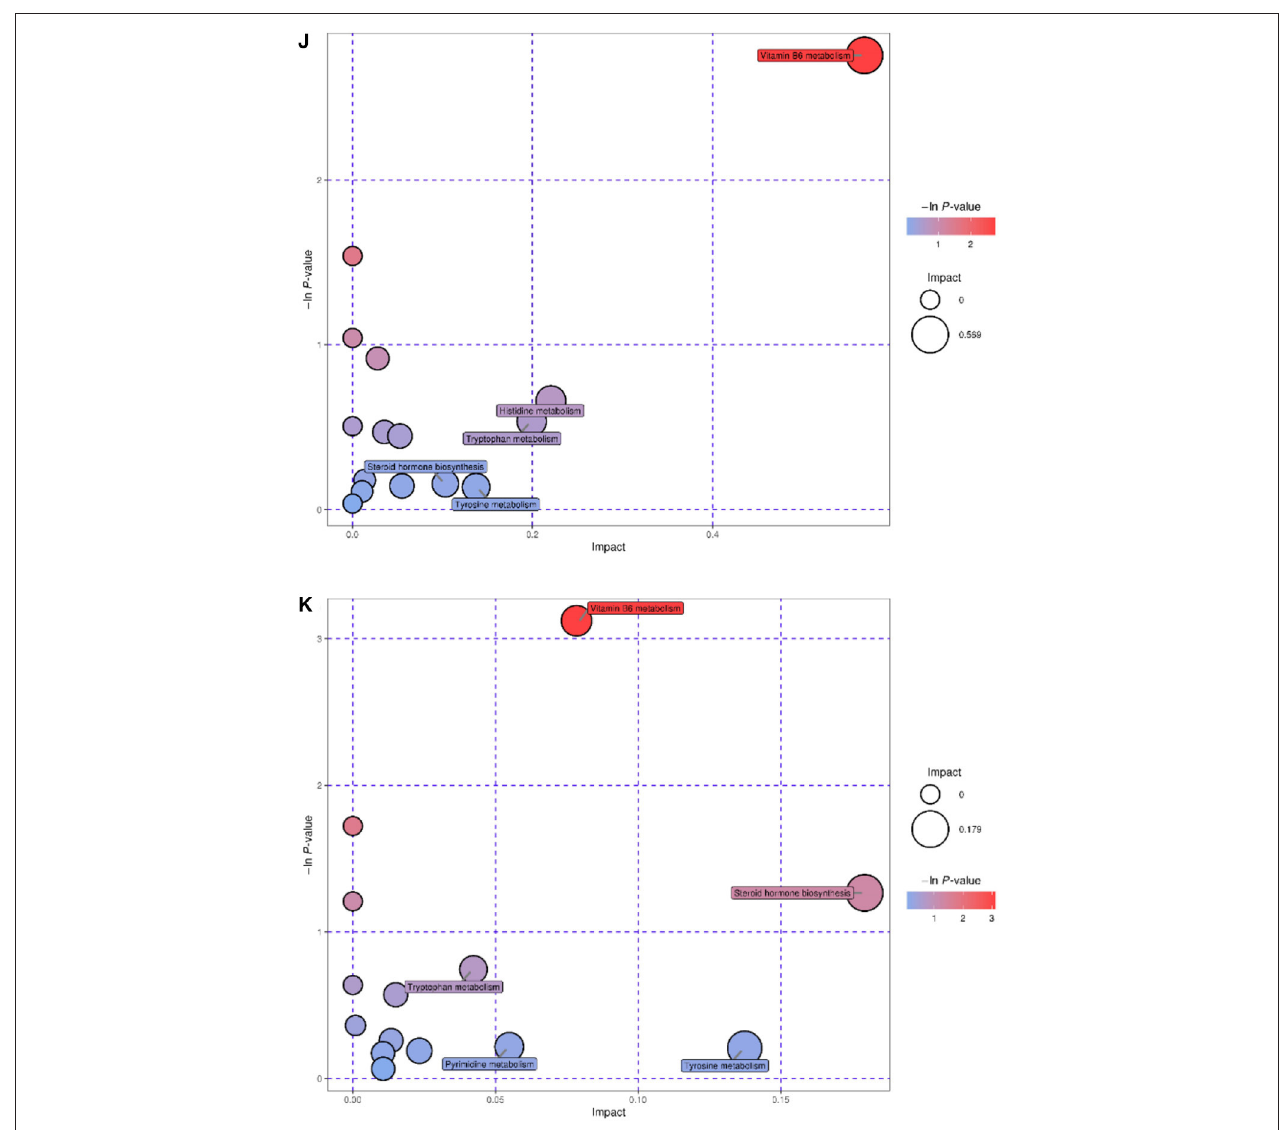
FIGURE 2 | Effect of diet intervention on the metabolites in the colon. (A) The contents of short-chain fatty acids (SCFAs). (B) The differentially expressed metabolites between LPG and CTG. (C) The differentially expressed metabolites between CG and LPG. (D) The differentially expressed metabolites between SPG and LPG. (E) The relative content of L-valine. (F) The relative content of L-isoleucine. (G) The relative content of L-phenylalanine. (H) The relative content of L-tryptophan. (I) Bobble plot of LPG to CTG. (J) The bobble plot of CG to LPG. (K) The bobble plot of SPG to LPG. Data are presented as mean ± SEM. Different letters indicate statistical differences among groups ( p < 0.05). CTG, control group; LPG, low protein group; CG, casein group; SPG, soy protein